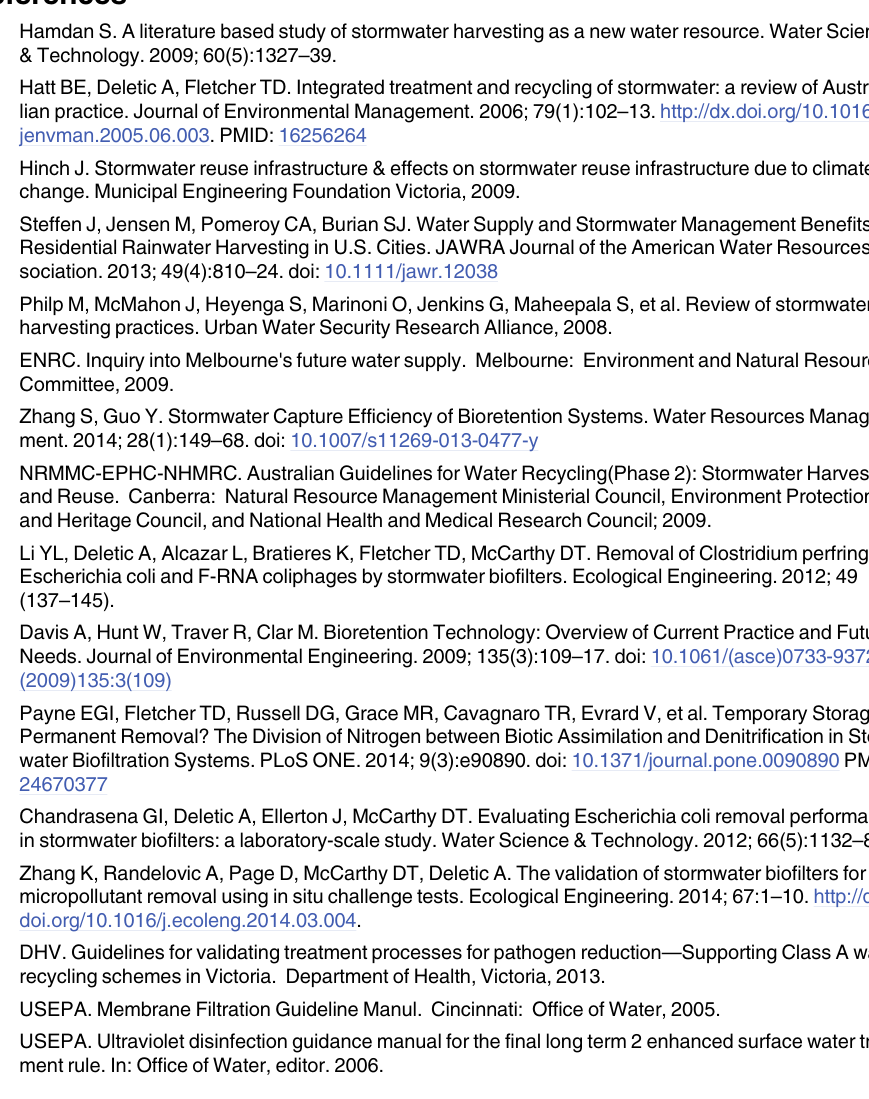
S8 Table. Fixed specifications for drainage link/stormwater network pipe in